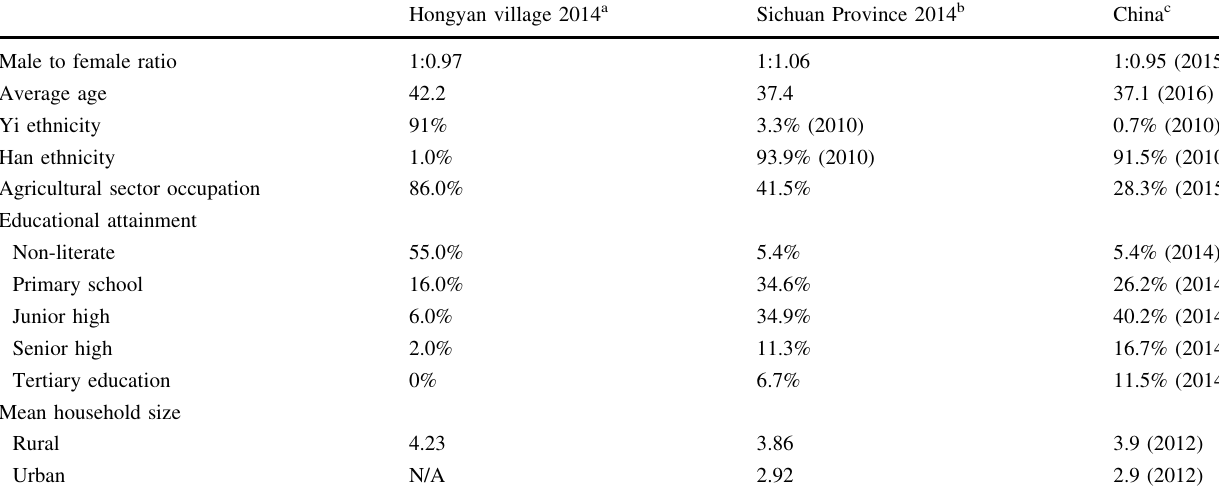
Table 1 Comparison of sociodemographic characteristics of Hongyan, Sichuan, and